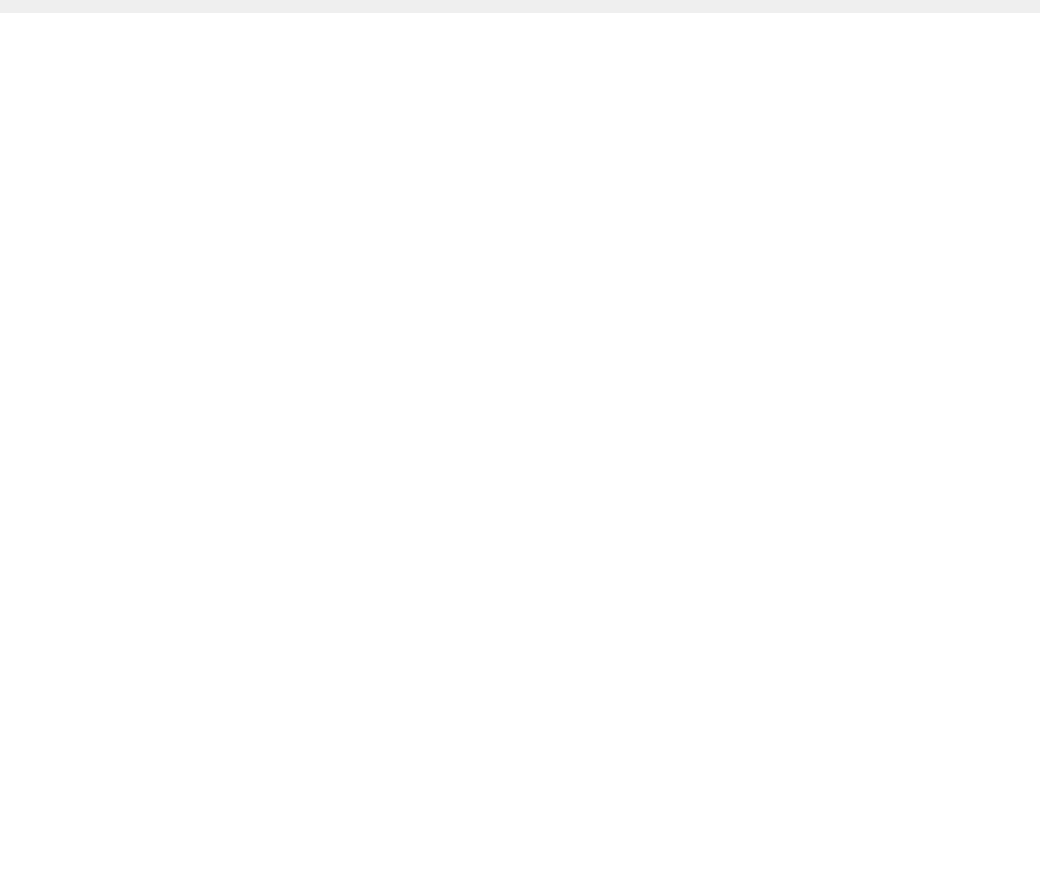
The total number of cases of CHD in groups 1–5, along with the number of prenatally diagnosed cases and their outcomes (live birth, stillbirth, and